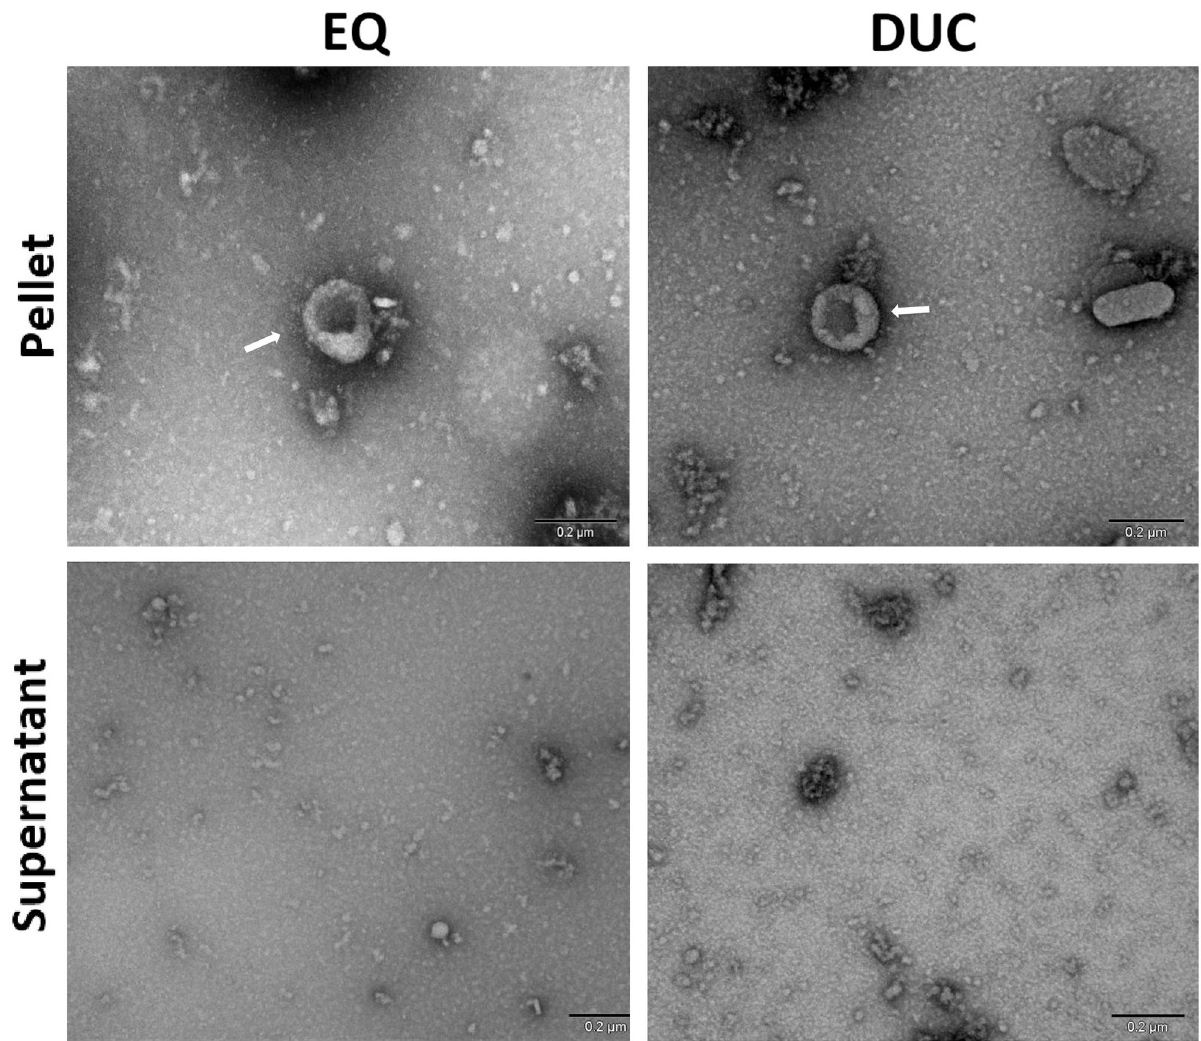
Fig 10. Morphology of human milk-derived exosomes visualized by Transmission Electron Microscopy (TEM) with negative staining (uranyl acetate). Human milk-derived exosomes were isolated via ExoQuick (EQ) precipitation and differential ultracentrifugation (DUC) methods. Scale bars: 200